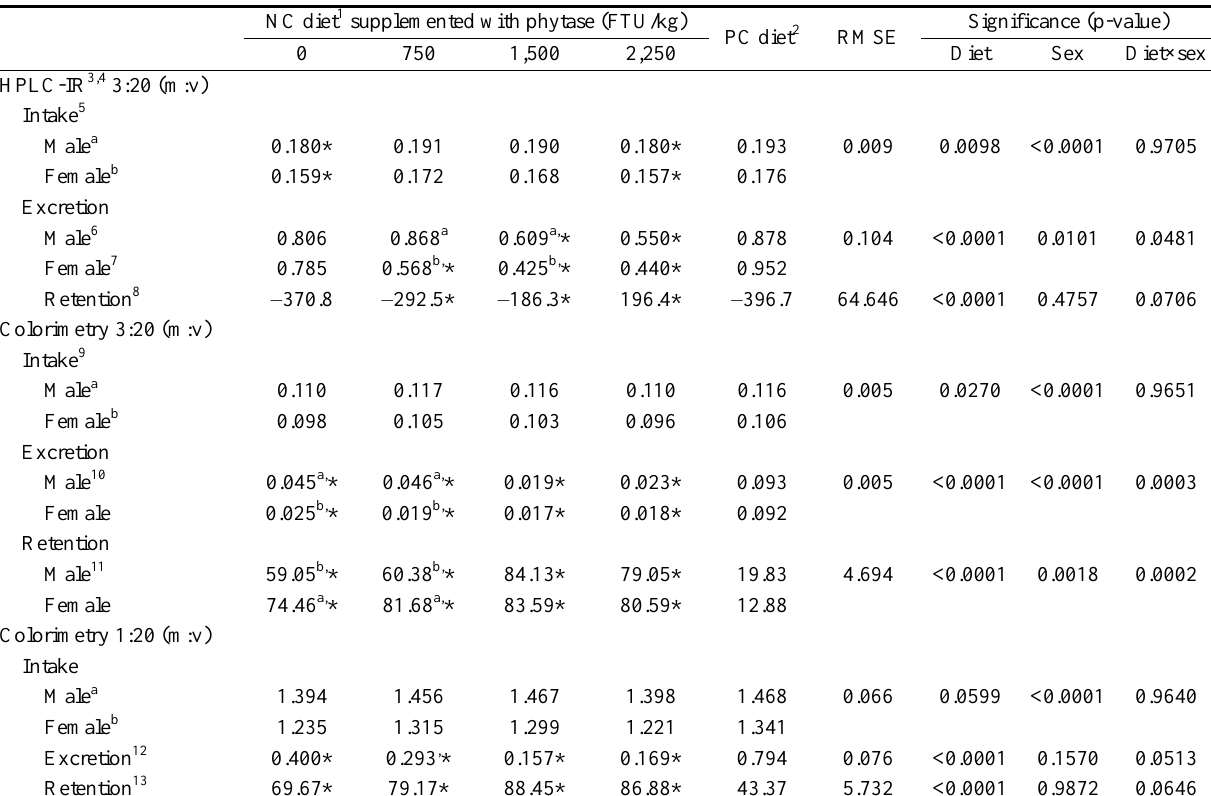
Table 4. Balance (g/bird) and retention (%) of phytate phosphorus (in dry matter) of male and female broilers fed diets deficient in available phosphorus supplemented with increasing levels of phytase, utilizing two analytical methodologies and extraction ratios for the determination of the content of phytate phosphorus in the diets and excreta NC diet 1 supplemented with phytase